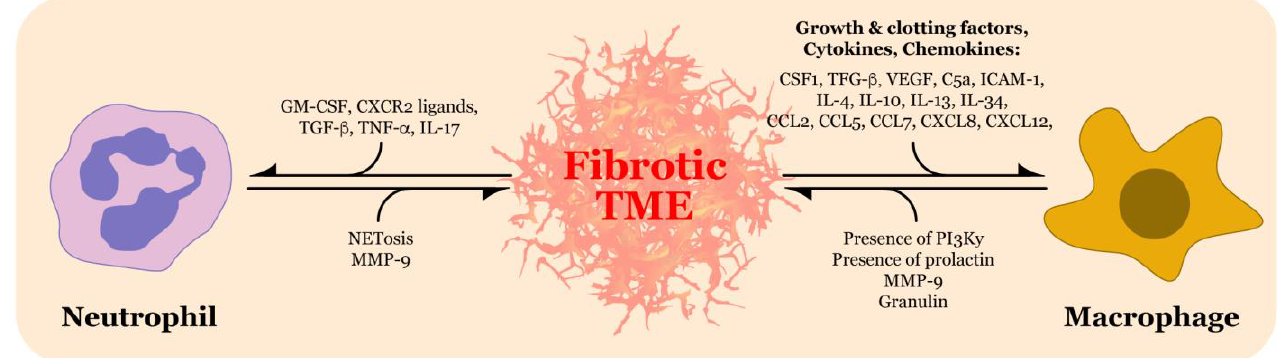
Figure 1. Crosstalk between the fibrotic tumor microenvironment (TME) and neutrophils and macrophages in pancreatic ductal adenocarcinoma. The fibrotic TME releases a variety of chemical mediators that recruit neutrophils and macrophages into the TME. In turn, neutrophils and macrophages possess characteristics and/or release their own factors that increase TME fibrosis. CSF1, colony stimulating factor 1; TGF-β, transforming growth factor-β; VEGF, vascular endothelial growth factor-A; C5a, complement component C5a; ICAM-1, intercellular adhesion molecule-1; IL, interleukin; CCL, chemokine (C-C motif) ligand; CXCL, chemokine (C-X-C motif) ligand; PI3Ky, phosphatidylinositol 3-kinase gamma; MMP-9, matrix metalloproteinase 9; GM-CSF, granulocyte-macrophage colony-stimulating factor; TNF-α, tumor necrosis factor-alpha; NETosis, neutrophil extracellular trap release.